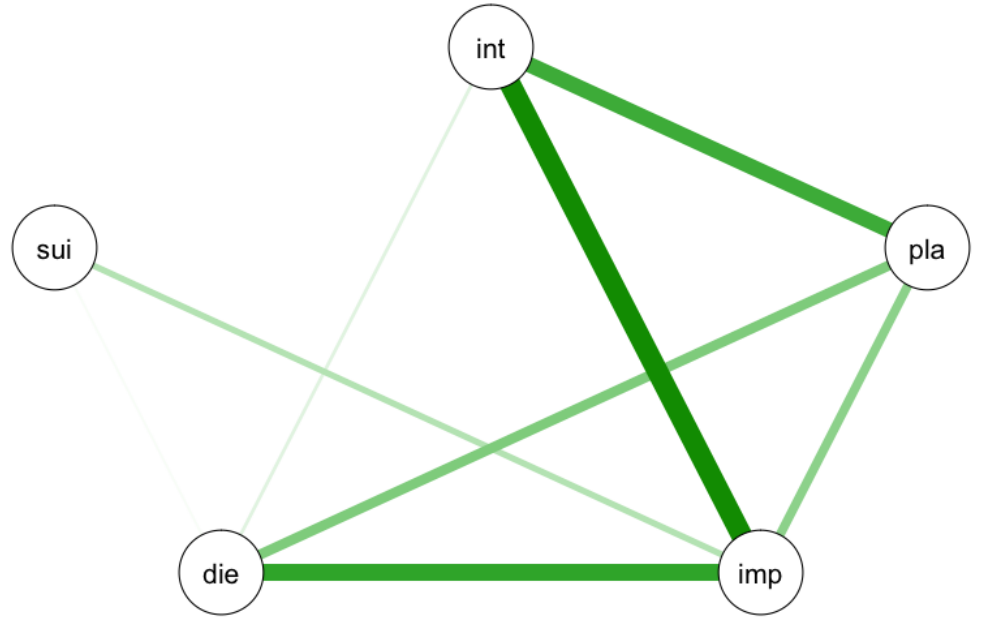
Figure 2. Hypothetical example of a network of suicidal symptoms. Int: intensity of suicidal thoughts; pla: concrete plans; imp: impulsivity; die: desire to die; sui: expectancy of suicidal behaviour. Green lines represent positive relationship. The thicker the line, the stronger the association.